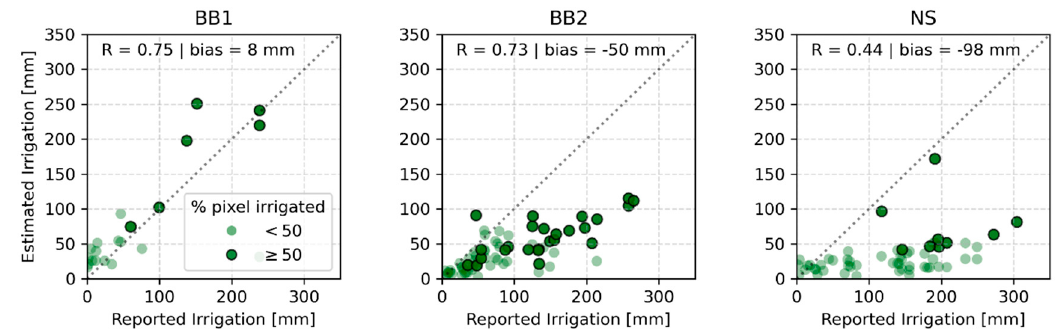
Figure 8. Pixel by pixel comparison of cumulative irrigation water heights between estimated and reference data. S1-SSM pixels with a fractional irrigation area higher than 50% are highlighted.